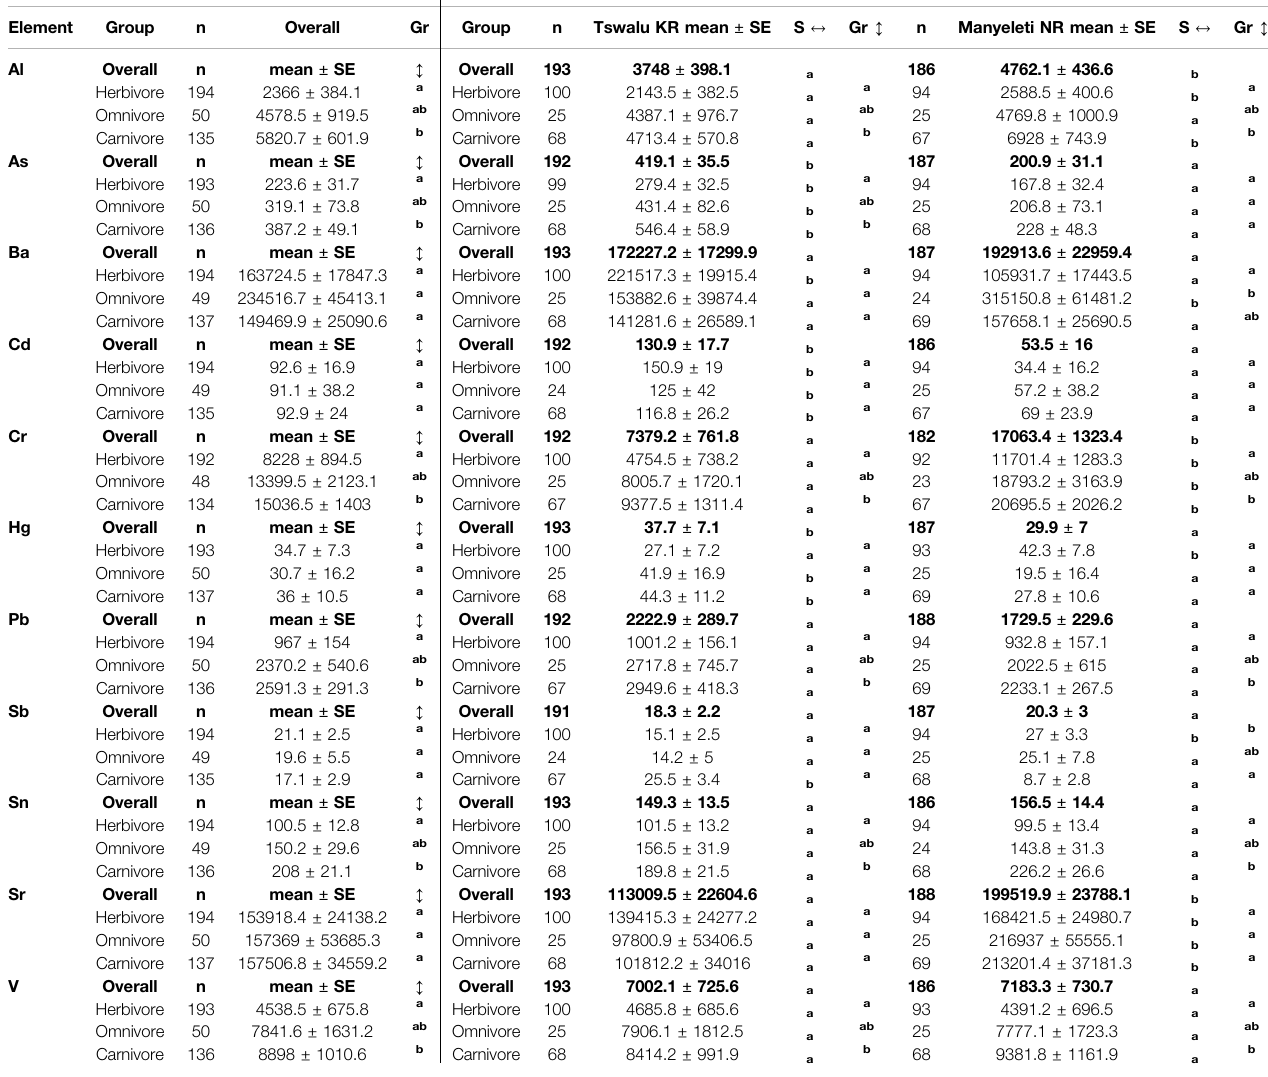
TABLE 1 | Estimates for potentially toxic element concentrations between animal groups overall (left) and between sites for any group (right). Note: Overall differences between groups are shown on the left of the table. Comparisons between sites (overall and in any group) and between groups (within each site) are shown on the right. Withinrowlettersubscriptsa,bindicateasigni fi cantdifferencebetweensites( p < 0.05)andwithincolumnlettersuperscriptsa,b,cindicatessigni fi cantdifferencesbetween groups ( p < 0.05). Faecal concentrations are given as microgram per kilogram (µg/kg) faecal dry mass